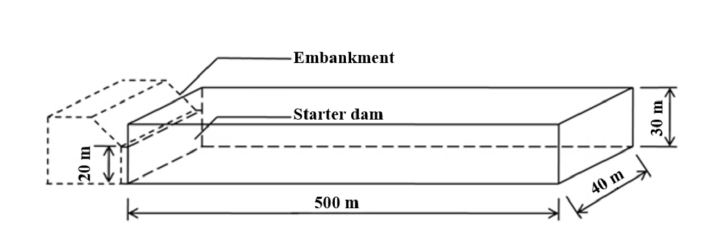
Figure 10. Simplified model of a tailings dam and the downstream channel.